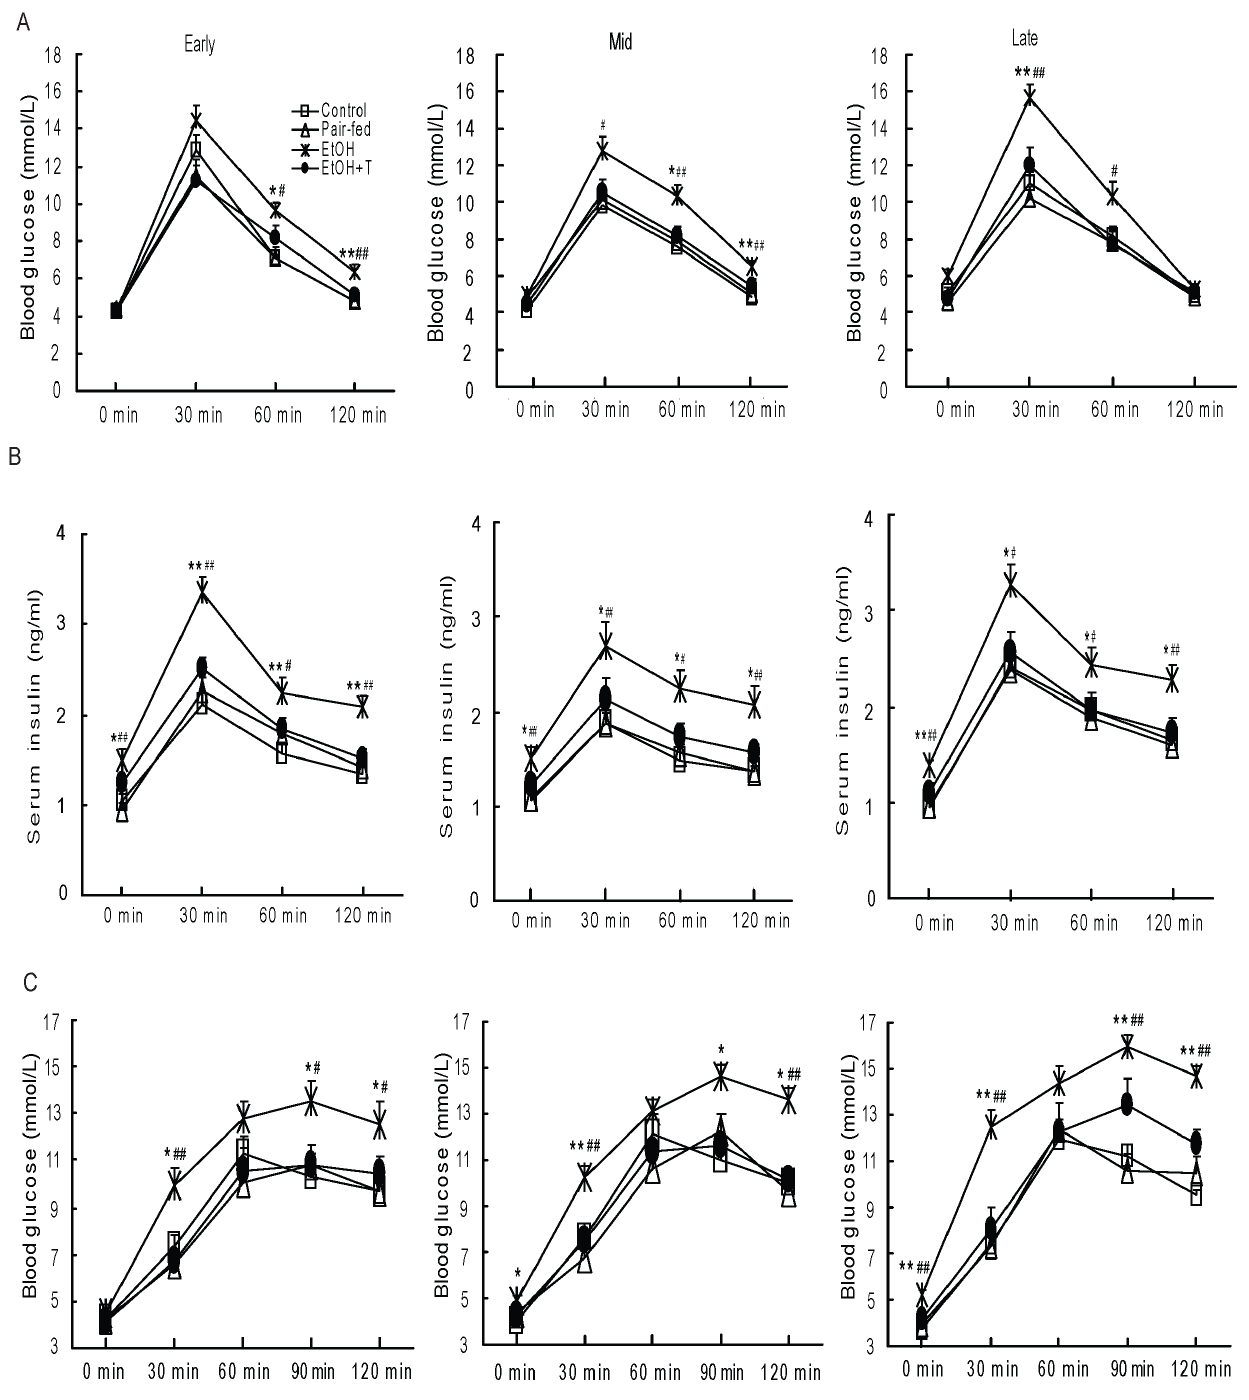
Figure 2. Blood glucose and insulin levels after intraperitoneal injection of glucose (A, B) and blood glucose after intraperitoneal injection of sodium pyruvate (C) in 4 month-old male rat offspring exposed to ethanol (EtOH) or water only during early, mid, or late pregnancy. Control and pair-fed offspring were from dams with free access to chow and dams fed the amount of chow consumed by EtOH dams, respectively. A subgroup of EtOH rats was given TUDCA (T) for 3 weeks before the measurements. Data shown as the mean 6 SE, n=6. *P , 0.05, **P , 0.01 EtOH vs. control; # P , 0.05, ## P , 0.01 EtOH vs. pair-fed. doi:10.1371/journal.pone.0059680.g002 Glucose (30% w/v), 2 g/kg body weight, was IP injected and Elisa kit, CrystalChem, Downers Grove, IL). The rats were killed saphenous vein blood (40 m l) was sequentially collected for the by exsanguination, and liver and plasma were stored, respectively, determination of glucose (Ascensia Elite XL, Bayer HealthCare, at 2 80 u C and 2 20 u C until used. Toronto, ON, Canada) and insulin (Ultrasensitive Rat Insulin